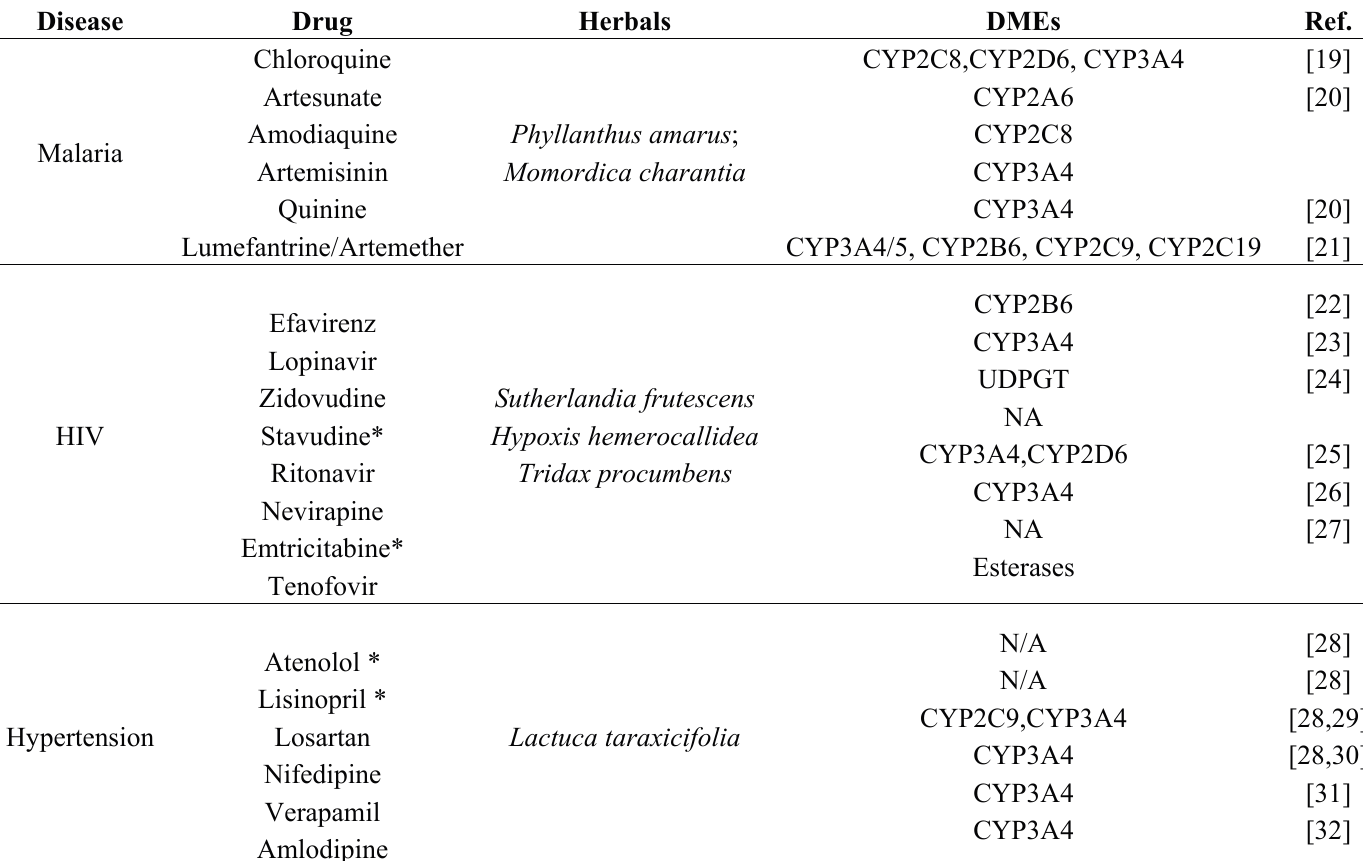
Table 1. Common drugs prescribed for malaria, hypertension, and HIV and their metabolizing